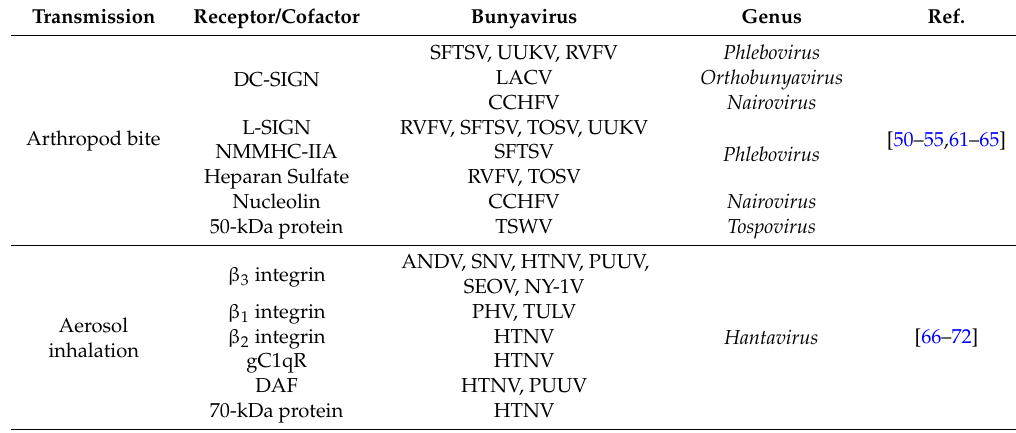
Table 1. Potential receptors documented for